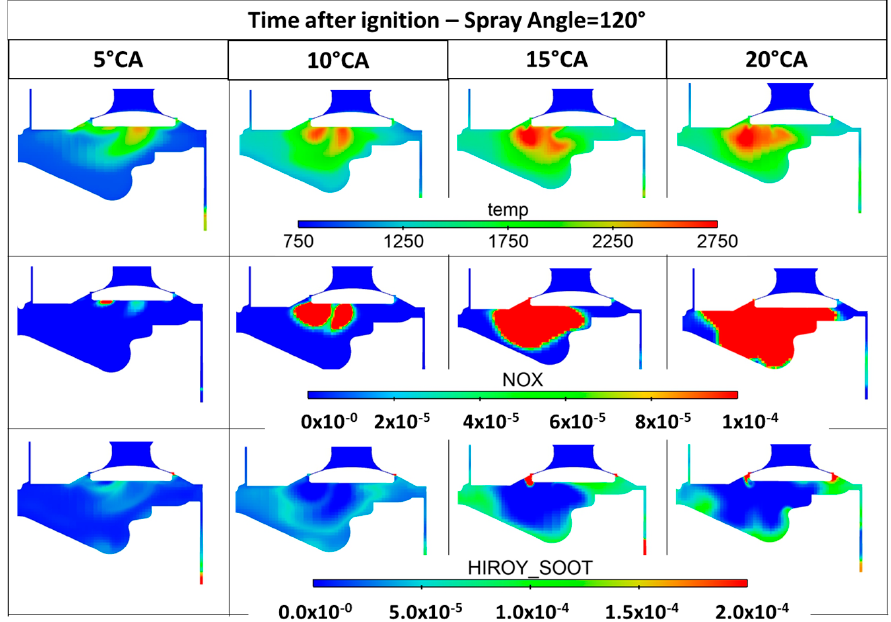
Figure 36. Evolution of in-cylinder temperature, NO x , and soot mass fraction contour plots in a plane formed by the cylinder axis and a spray axis at 5, 10, 15, and 20 ◦ CA after SOIgn for an SIA of 120 ◦ . For an SIA of 140 ◦ , a negligible amount of NO x is formed in the squish region, which is only because the premixed combustion of the lean FVAM is confined to a small fraction of the combustion chamber near the cylinder head and valves, where the temperatures range between 1750 K and 2250 K. Therefore, the smallest NO x emissions occur for an SIA of 140 ◦ among the various SIA cases considered in this